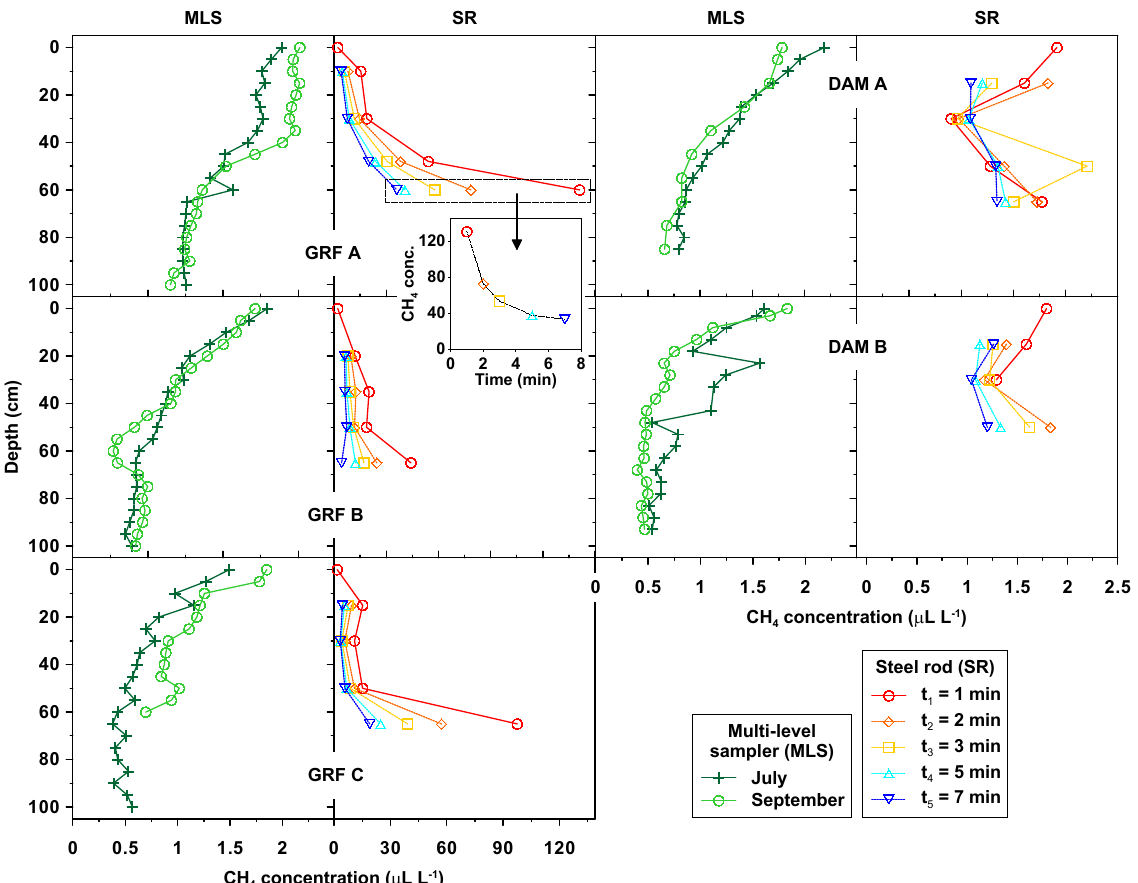
Fig. 1. Soil-CH 4 profiles obtained from the MLS and the SR time-series soil-gas samples. The red SR samples ( t 1 ) can be directly compared to profiles for which each depth is sampled only once. Note the different scales of the x axis for the SR profiles in GRF and DAM graphs.